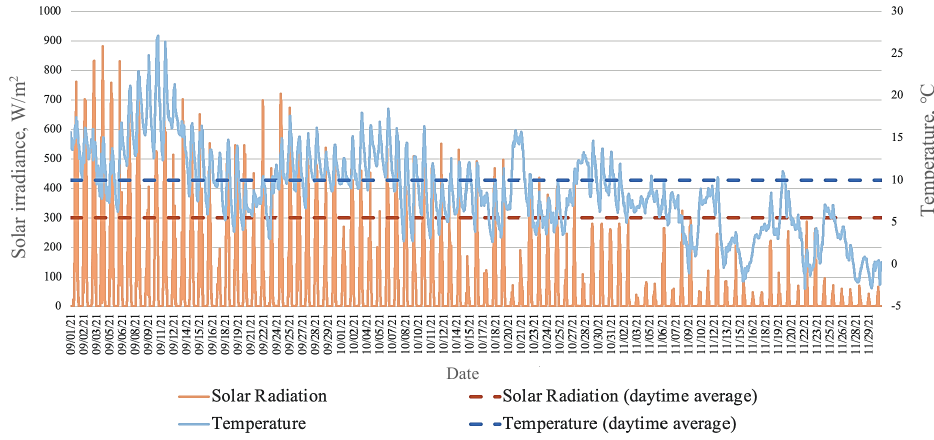
Fig. 6. Data from the Riga Technical University metrological station from September to December 2021. The experiments were conducted in the climate chamber where the ambient temperature was set to 10 °C. The experiment takes place for 16 hours – 8 h with solar radiation simulation (‘daytime’ phase) and 8 h without solar radiation (‘nighttime’ phase). The blades of the dynamic component were static in this experiment. Two positions were set – during the ‘daytime’ blades were open and concentrated the light from the lamps to the center of Fresnel lens, but in the nighttime, blades were in a closed position, to reduce heat losses from PCM to the surroundings. Test conditions are summarised in the Table